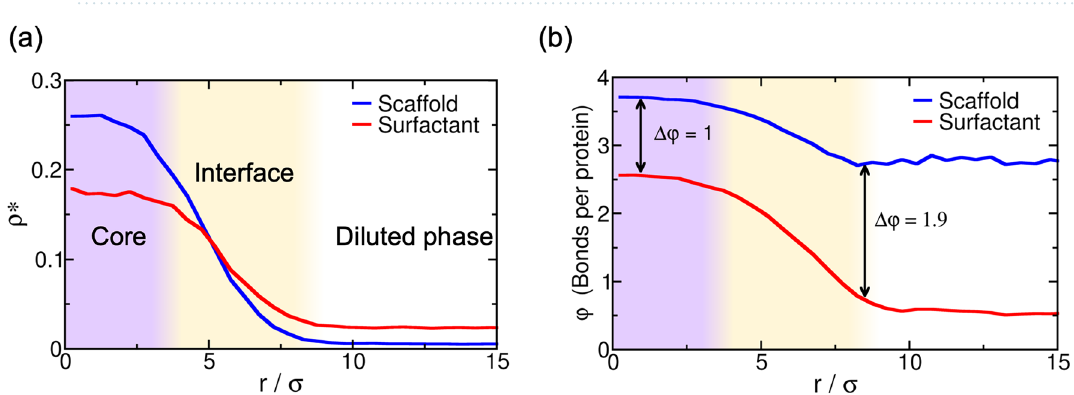
Figure 4. ( a ) Droplet density profile (in reduced units) for scaffold (blue) and surfactant proteins (red) from the droplet center of mass towards the surrounding diluted phase for the 50:50 binary mixture within the simulation box geometry shown in Fig. 2a at T ∗ / T ∗ c = 0.75 . ( b ) Average number of engaged binding sites per protein ( ϕ ) as a function of distance from the droplet center of mass for scaffold (blue) and surfactant proteins (red). One binding site is considered to be engaged to another if the distance between them is less than 0.145 σ (i.e., the maximum bond length interaction between distinct protein binding sites; for further details on these calculations see Supporting